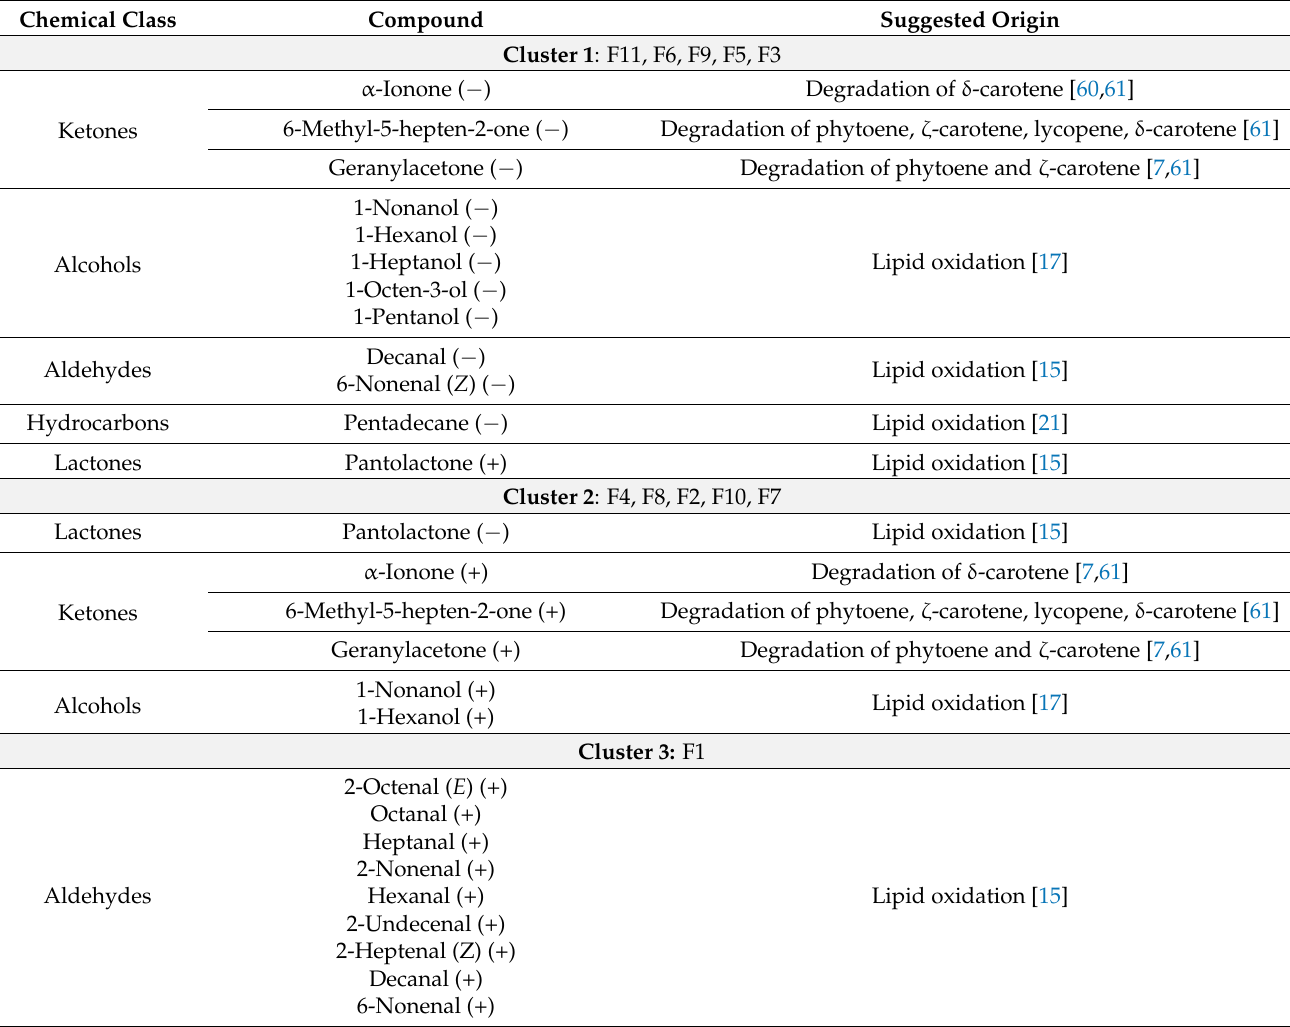
Figure 3. Dendrogram of cluster analysis of traditional maize flours. Table 3. Maize flours’ volatile compounds that contributed to discriminate the different